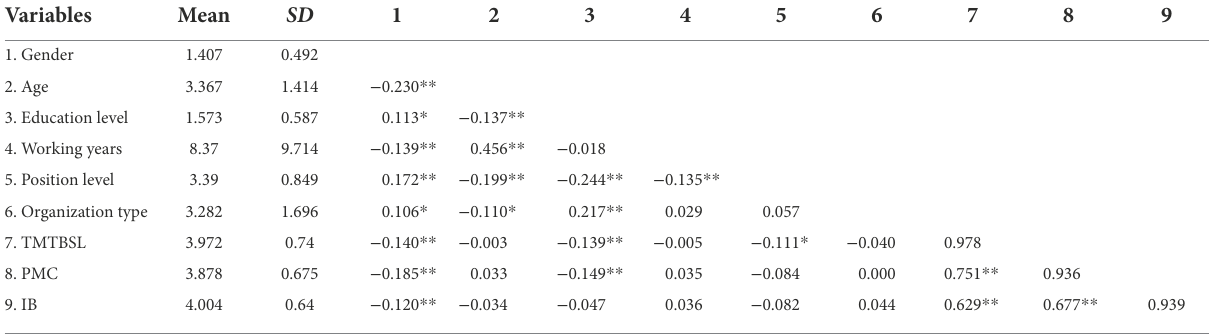
TABLE 6 Means, standard deviations, scale reliabilities and correlations of all variables involved in Study 2.